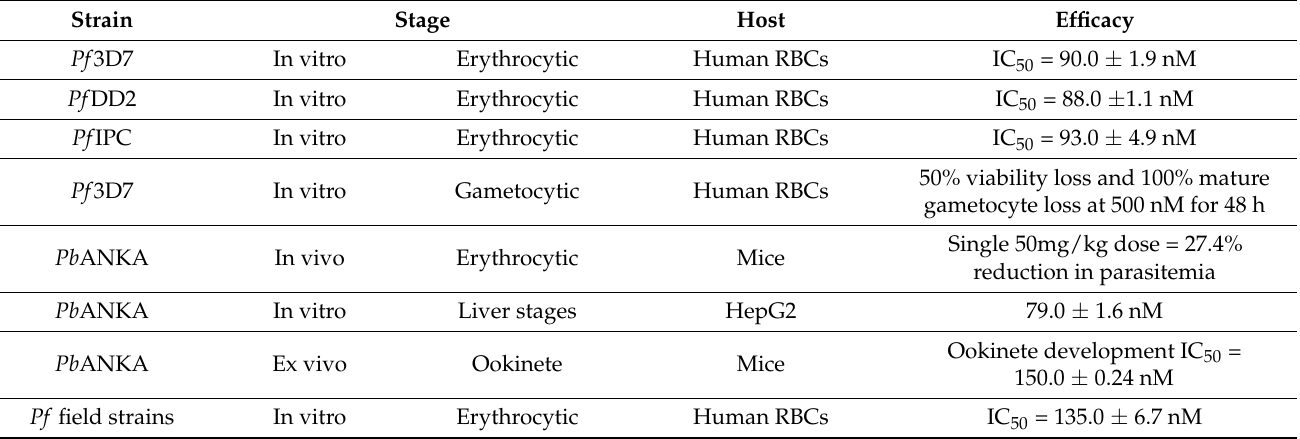
Table 1. Antiparasitic IC 50 breakpoints of Calxinin among different stages and against Pf and Pb in vitro and in vivo models. Mean IC 50 (M ± SD) values of 3 biological replicates, and each replicate has like 10 dose concentration samples/treatments (total number of samples n =